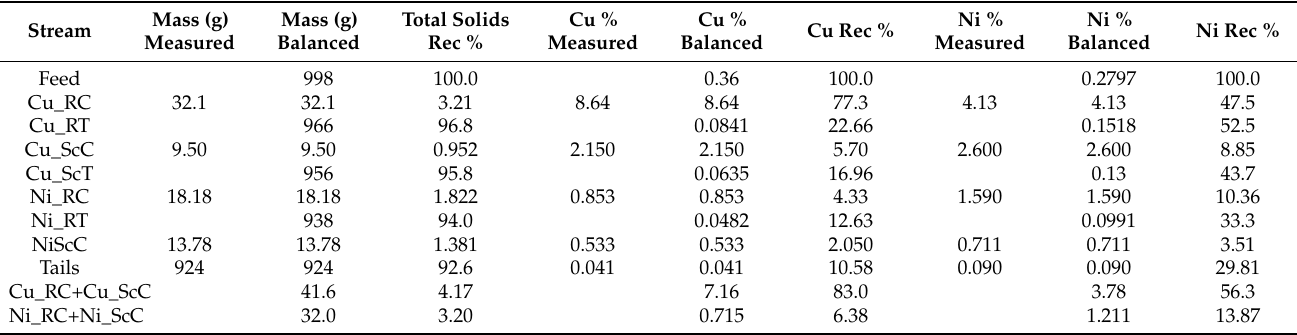
Table A5. Mass balance for flotation test Sep 11_01.